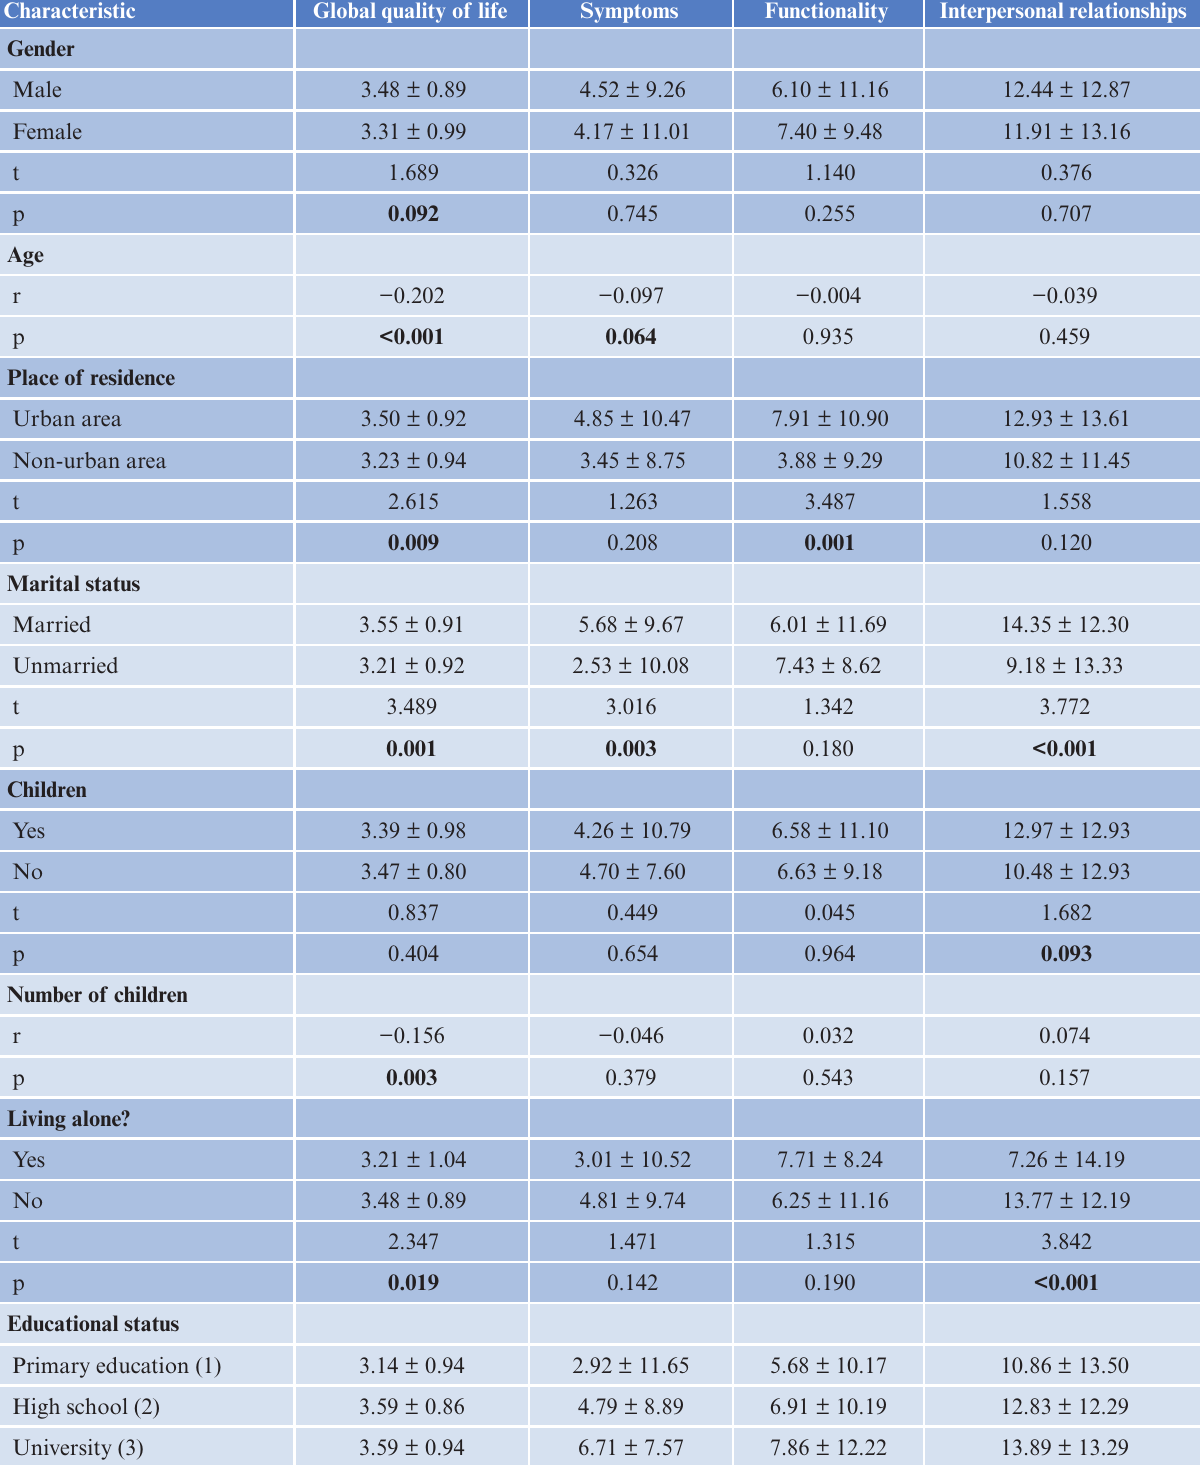
Table 1. Association of QoL and patient’s characteristics (n = 367) Characteristic Global quality of life Symptoms Functionality Interpersonal